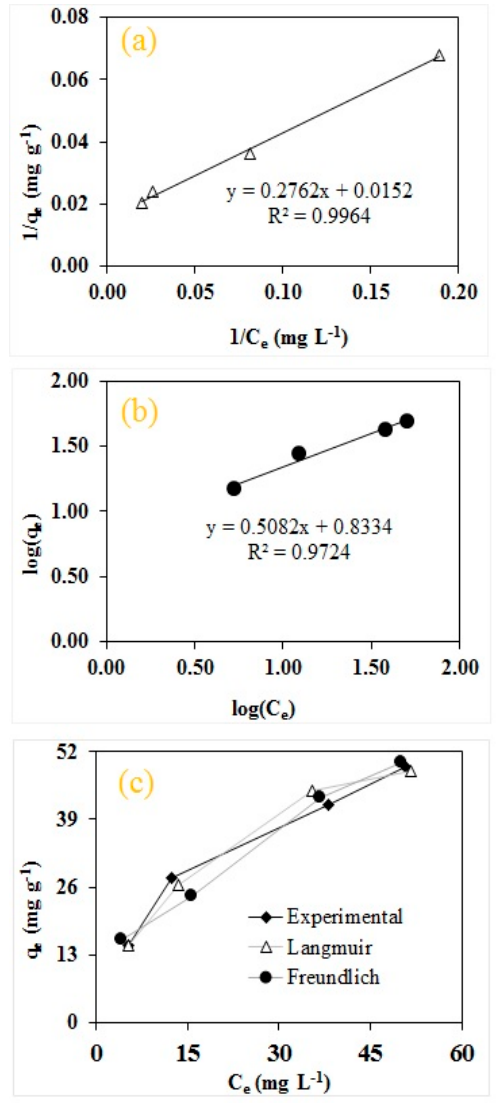
Figure 9. Isotherm plots for RO16 adsorption onto MA-AC400: ( a ) Langmuir; ( b ) Freundlich; ( c ) deviation of predicted adsorption capacities calculated by Langmuir and Freundlich isotherms with the experimental value.